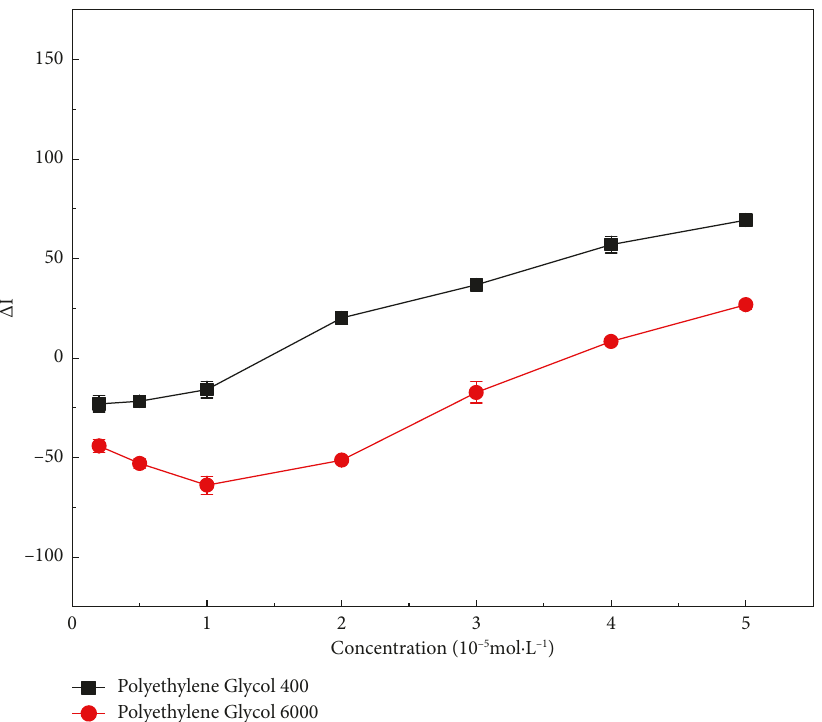
Figure 5: Resonant Rayleigh scattering spectra after addition of nonionic surfactant to congo red-neomycin system. The concentration of polyethylene glycol 400 and polyethylene glycol 6000:0.2, 0.5, 1, 2, 3, 4, 5